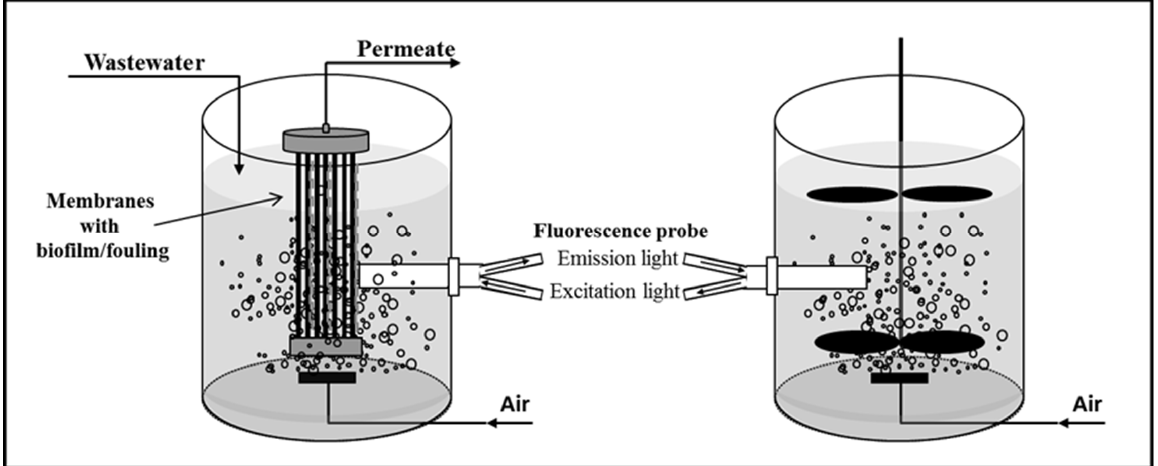
Figure 1. Acquisition of 2D fluorescence scans at membrane surface in submerged membrane bio- reactors ( left ) and in bulk solution of bioreactors ( right ) using optical probes.